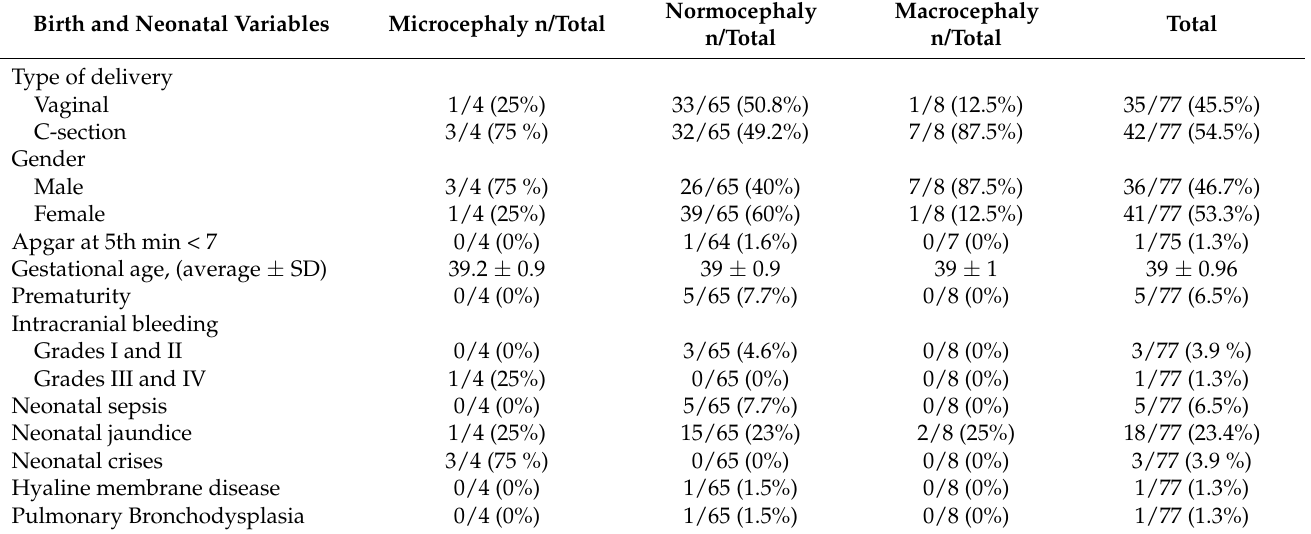
Figure 1. Physical characteristics of children exposed to Zika virus in the intrauterine period, in Manaus, Brazil: ( a ) A normocephalic boy without neuropsychomotor-developmental delays or abnormalities in the physical-neurological examination; ( b ) A child with macrocephaly which evolved to normalization of the cephalic perimeter; ( c ) A boy with microcephaly and spastic tetraparesis due to congenital- Zika-virus syndrome; ( d ) Supernumerary-hair-swirl alteration. Table 2. Characteristics related to birth and neonatal period observed in 77 children exposed to Zika virus in the intrauterine period distributed according to the head circumference at birth, Manaus, Brazil.